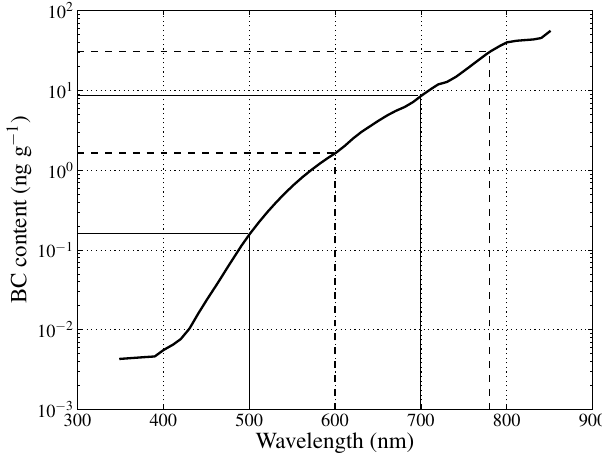
Fig. 4. Black carbon content beyond which black carbon absorp- tion represents more than 5% of the snow absorption coefficient. The curve is deduced from Eq. (25). The dashed lines highlight the values at 600nm and 780nm (wavelengths used for the Alpine mea- surements) and the continuous lines highlight the values at 500nm and 700nm (wavelengths used for Dome C